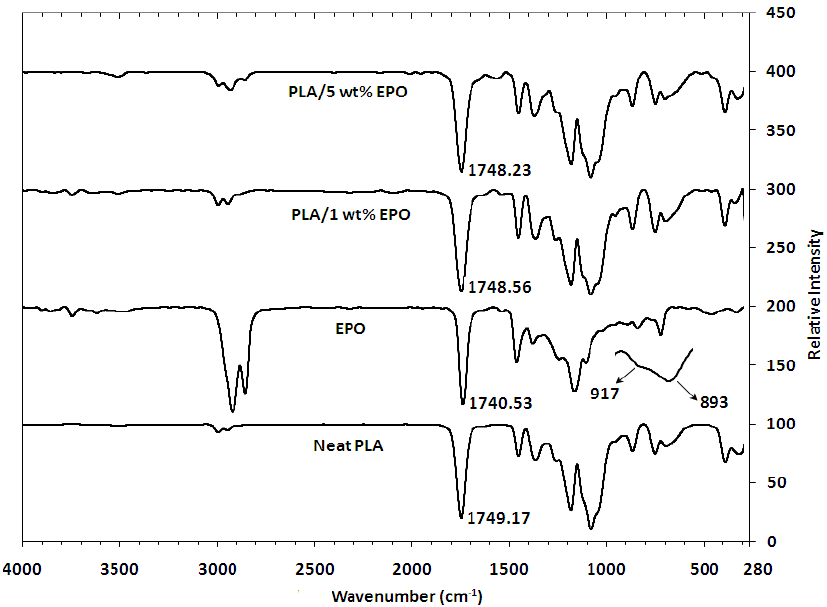
Figure 6. FTIR spectrum of neat PLA, EPO and PLA/EPO